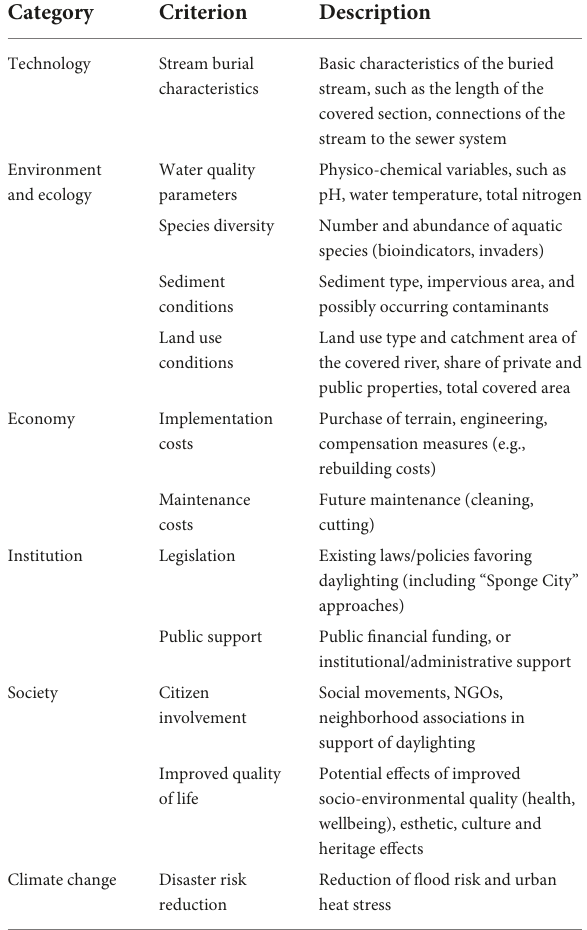
TABLE 7 List of the criteria for prioritization of daylighting